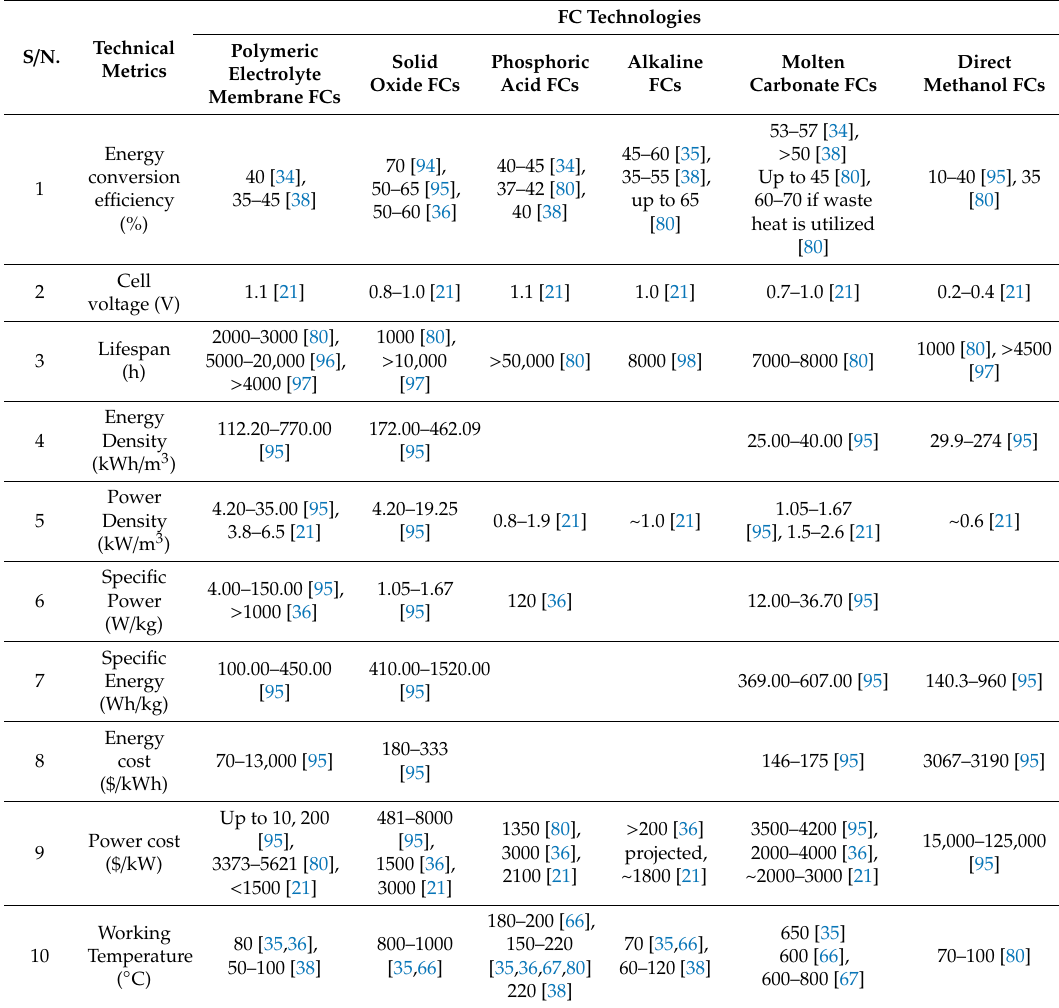
Table 2. Comparison of evaluative metrics of the FC